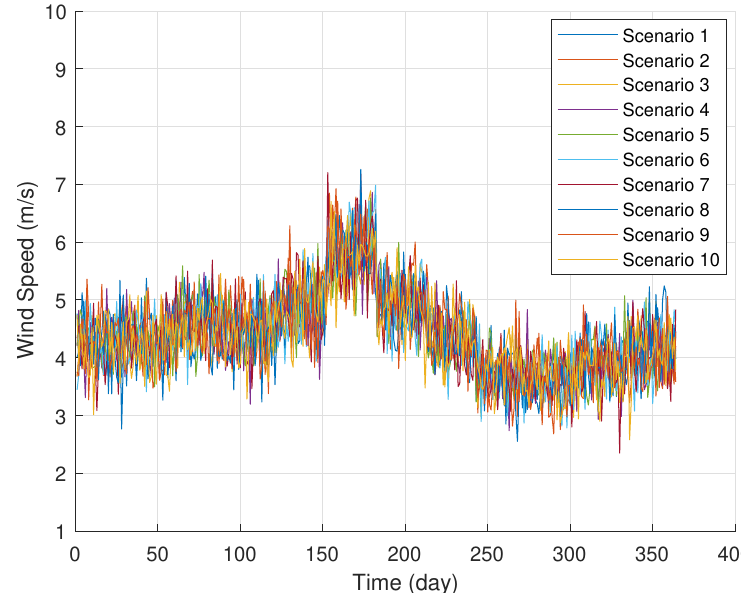
Figure 10. Average daily wind speeds of the ten scenarios.